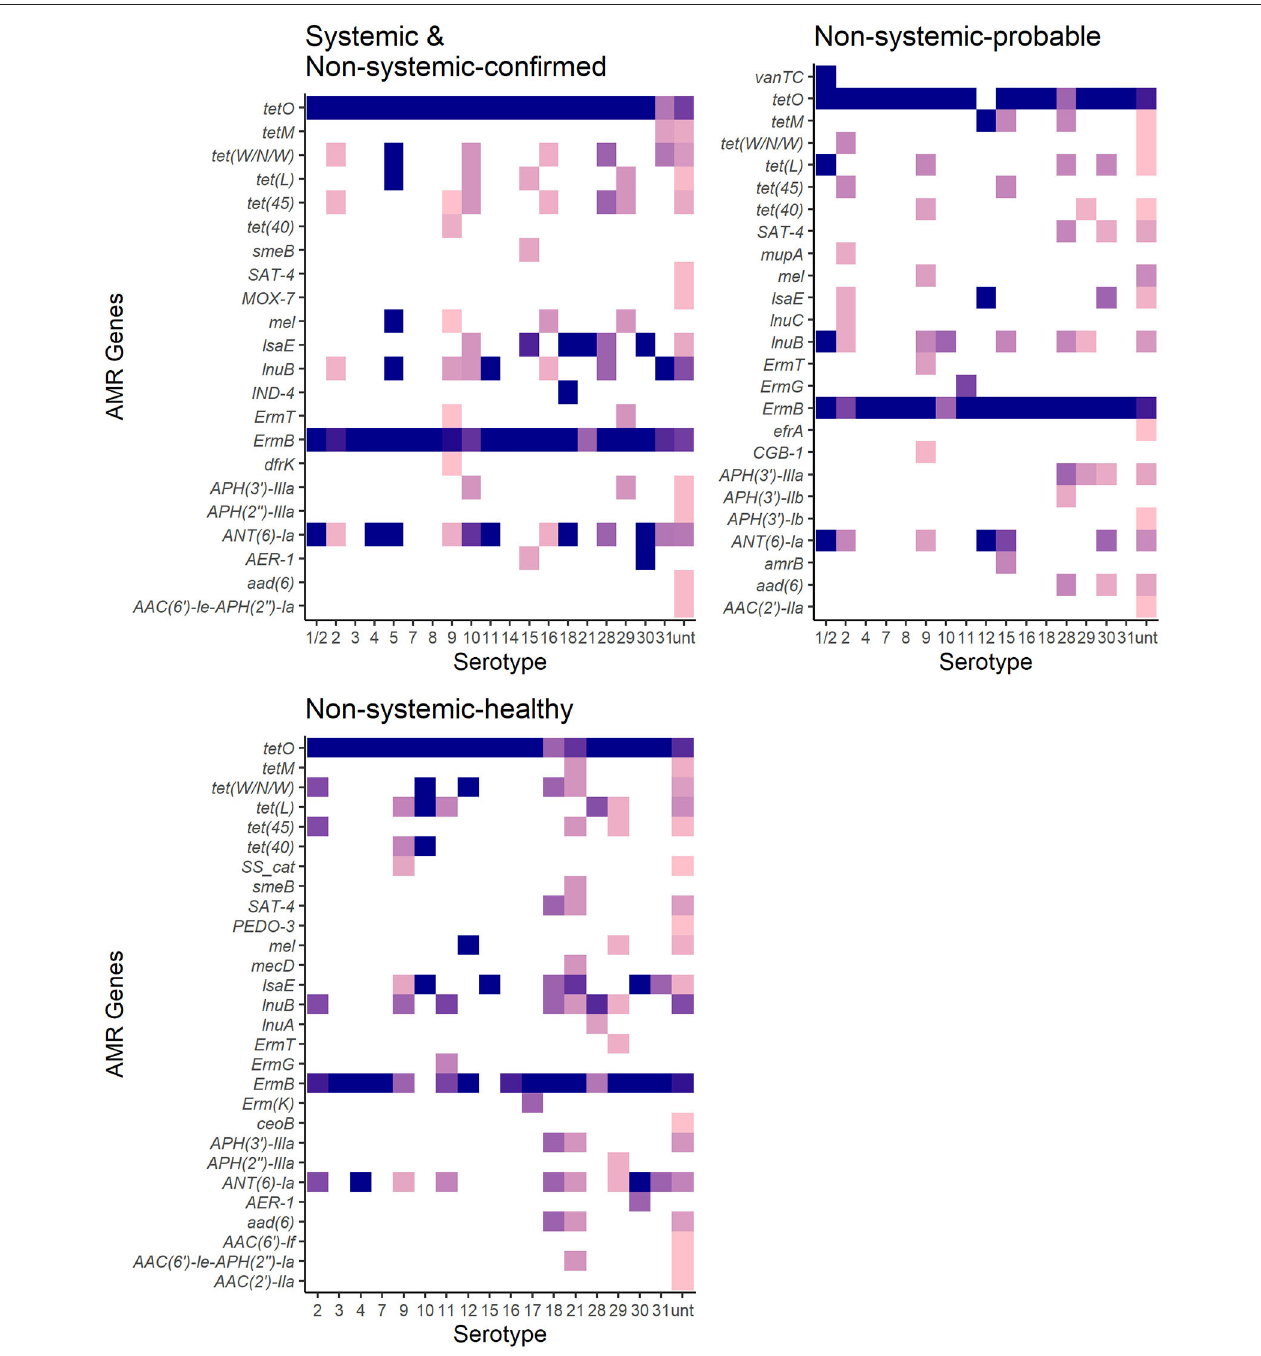
FIGURE 5 | Antimicrobial resistance genes distribution in 267 S. suis isolates from SC and NSC and NSP and NSH groups. Darker shades show a higher proportion of isolates of serotypes carrying a particular gene. White indicates an absence of gene in that serotype.